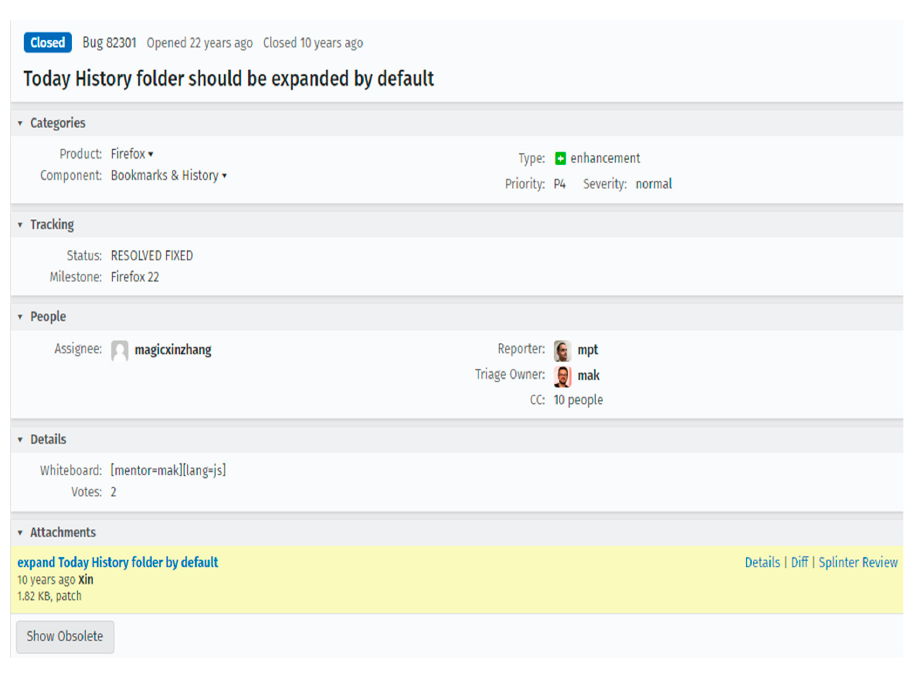
Figure 2. An example of Mozilla Firefox bug